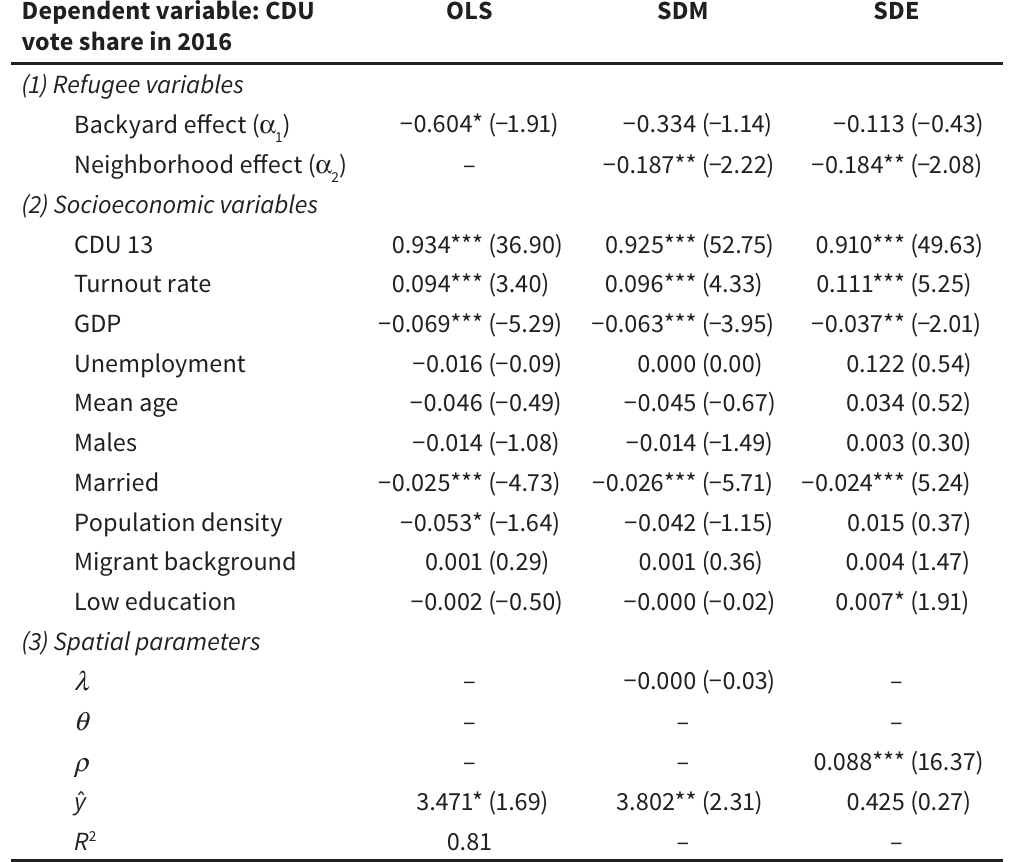
Vote share estimates for the CDU in the year 2016 (in percentage points) Dependent variable: CDU vote share in